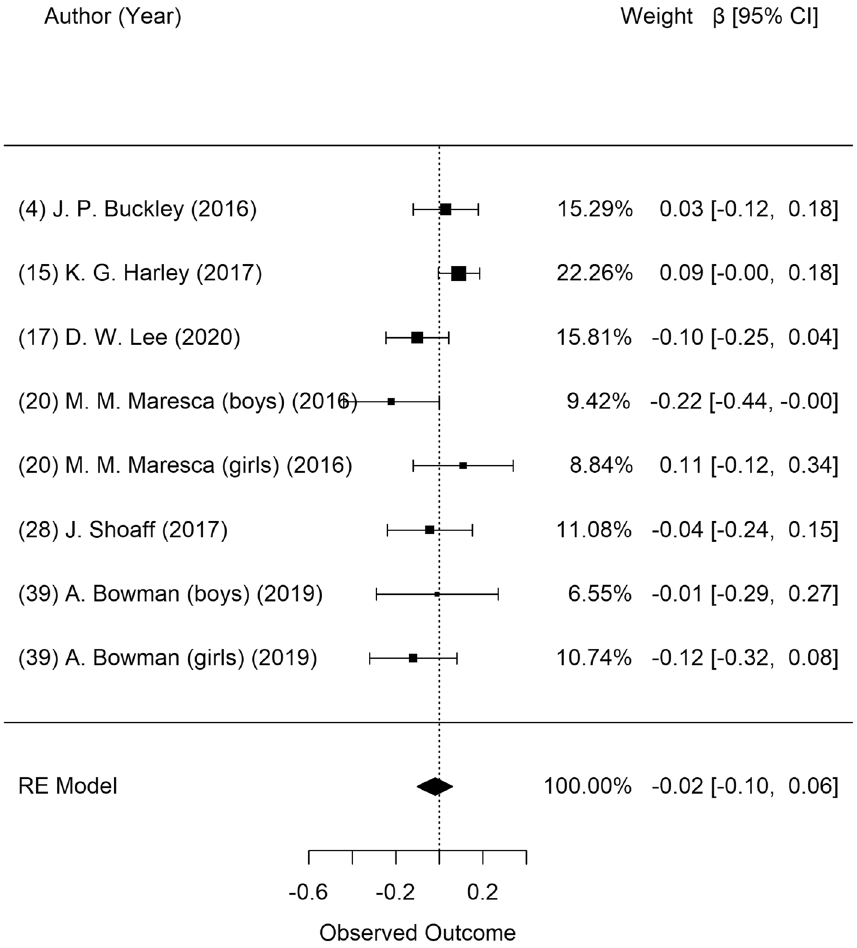
Figure 3. Forest plot of studies on the association of DBP exposure with BMI z-scores: longitudinal studies. Estimates were standardized as β and 95% confidence intervals as one unit increase of natural log of DBP